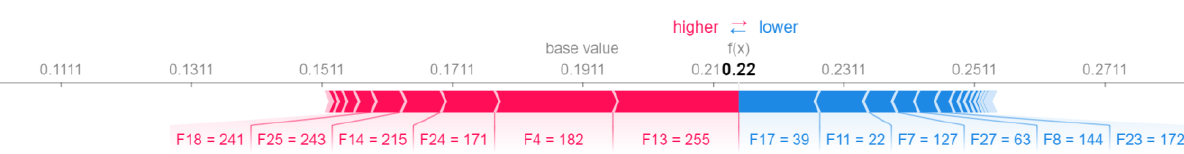
Figure 9. Most significant features.